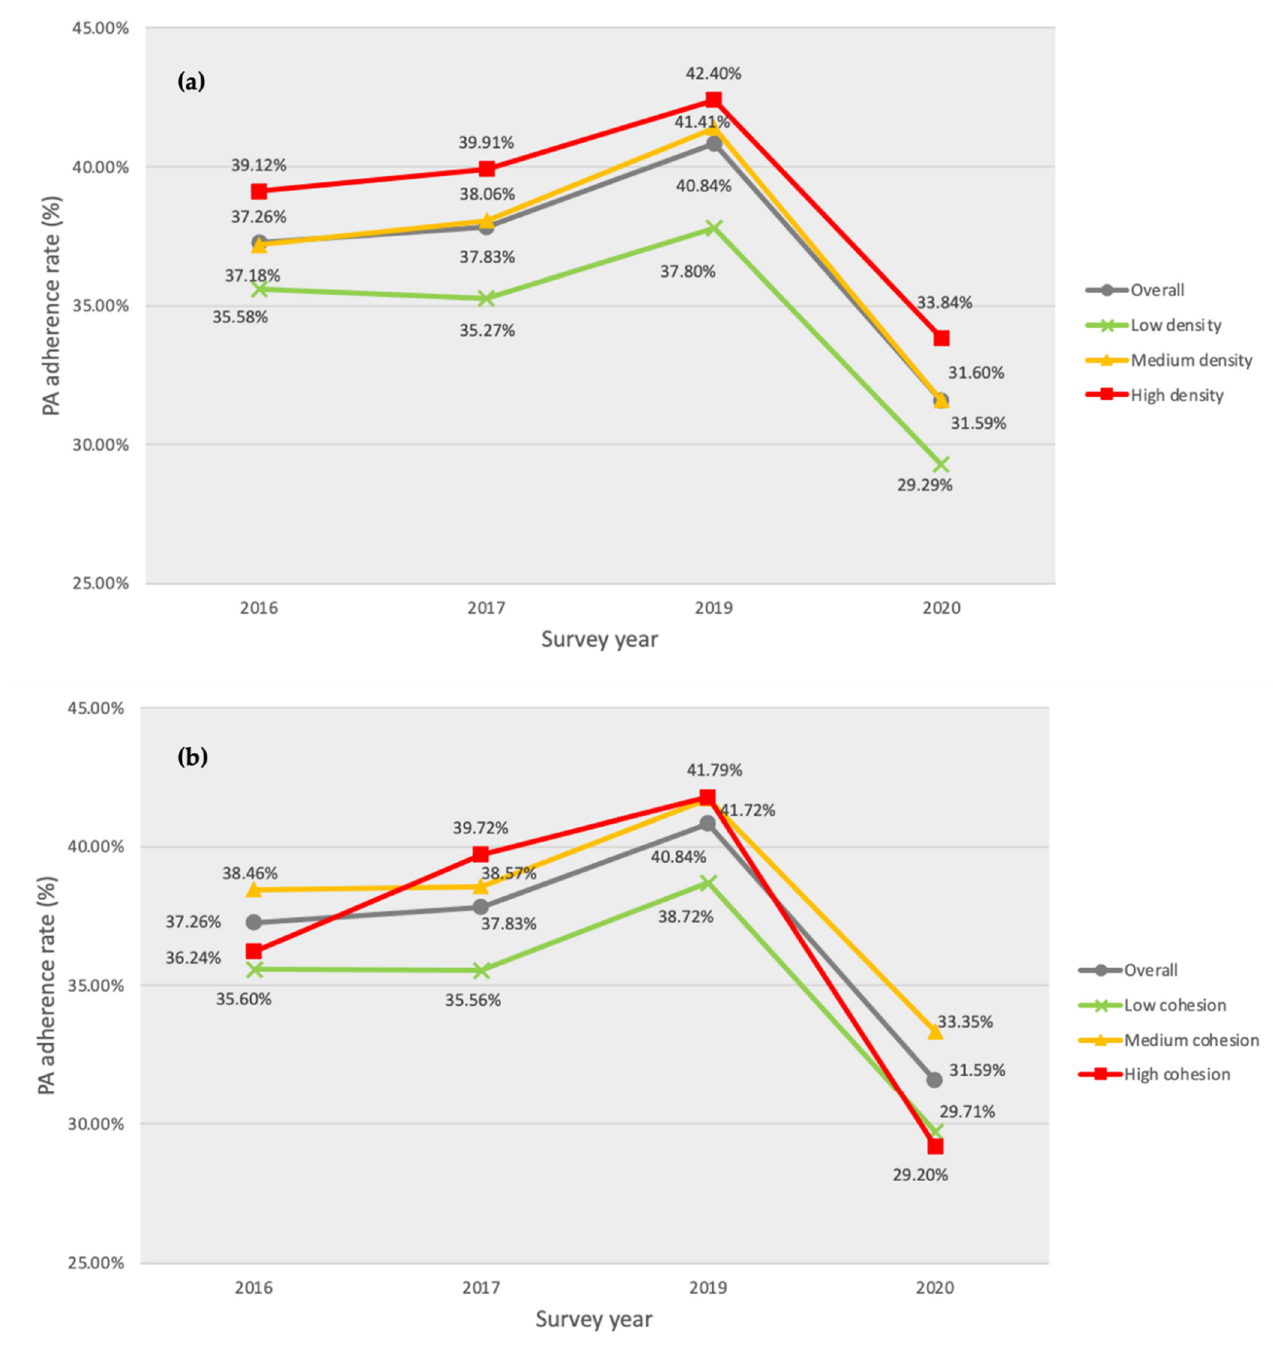
Figure 2. Five-year aerobic physical activity guideline adherence rate trends by community characteristics. ( a ) Density of sport facilities (number of sport facilities per 1000 persons), and ( b ) social cohesion.